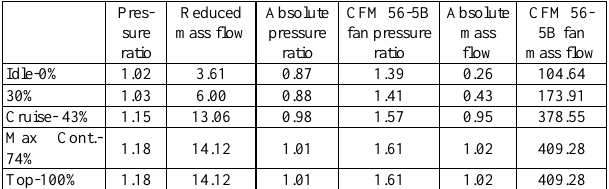
Table 7. Parameter of CFM 56-5B V = 0 Ma, H = 2000 m